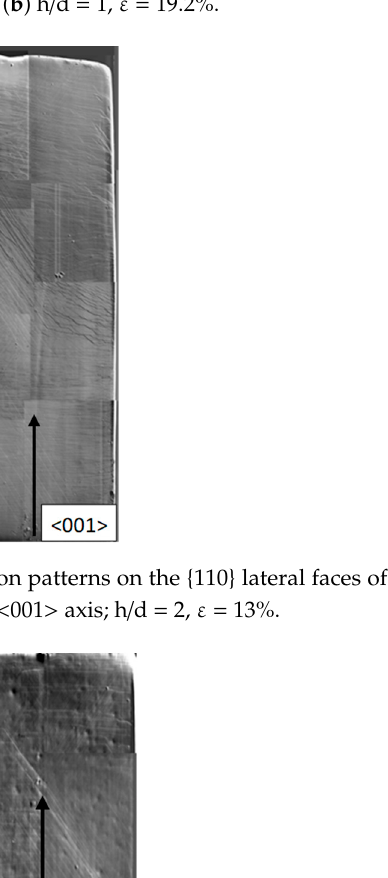
Figure 9. Surface deformation patterns in a simulated <001> Al single crystal with {110} lateral faces: ( a ) h / d = 2, ε = 23.6%; ( b ) h / d = 1, ε = 19.2%.